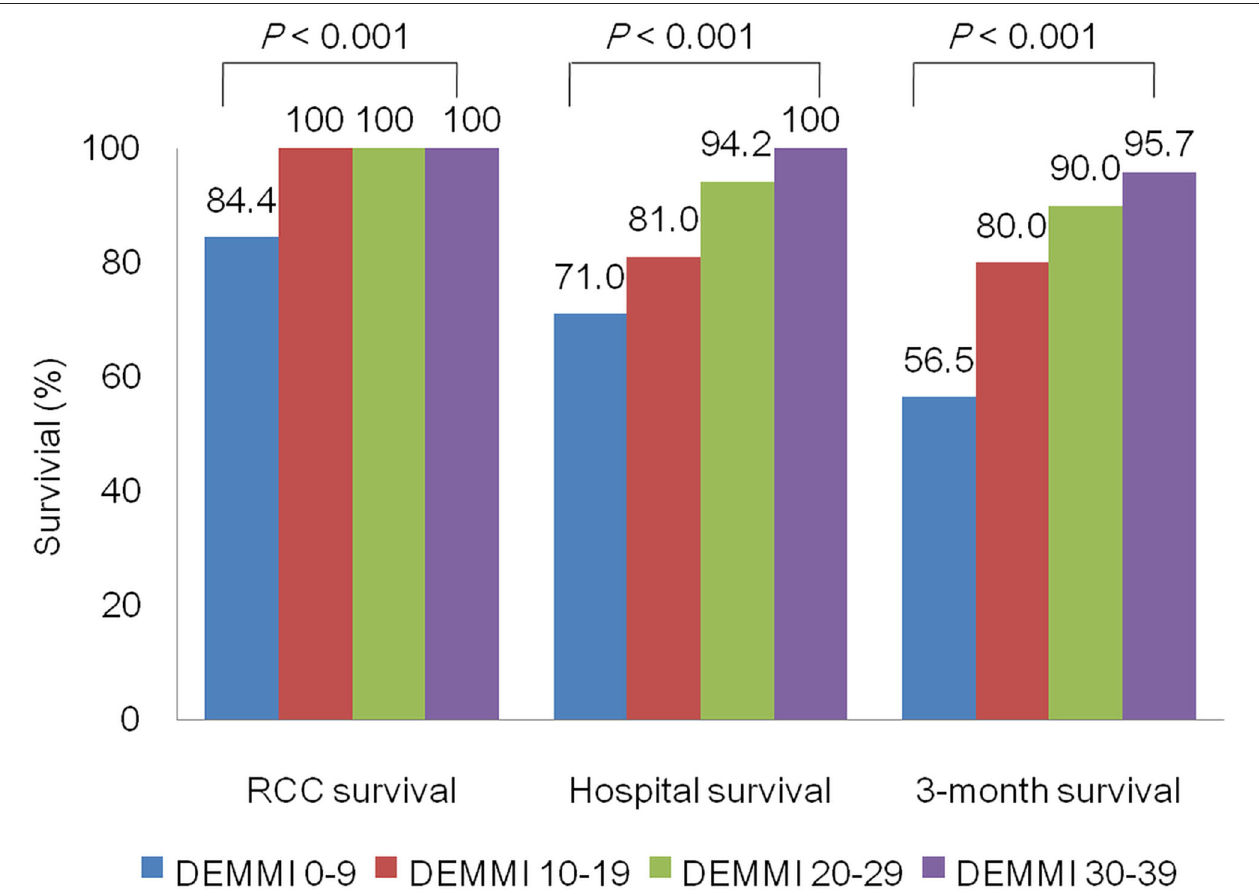
FIGURE 2 | Comparison of survival status among patients of different post-rehabilitation DEMMI group. DEMMI, the de Morton Mobility Index; RCC, respiratory care center.